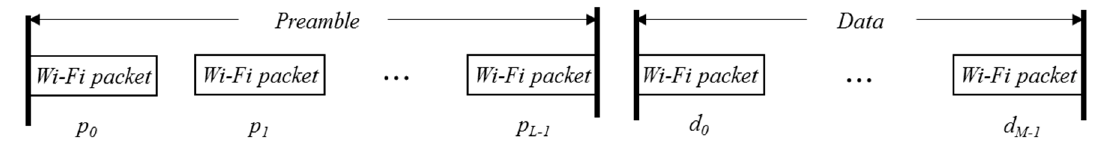
Figure 2. Frame structure in the proposed system.